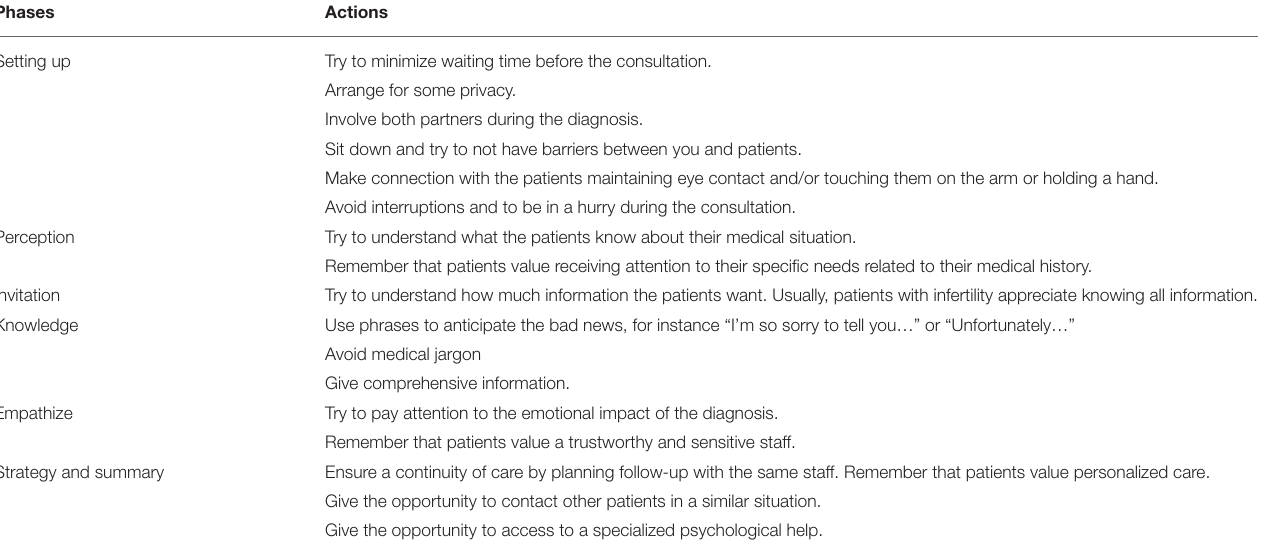
TABLE 3 | SPIKES protocol for infertility diagnosis.